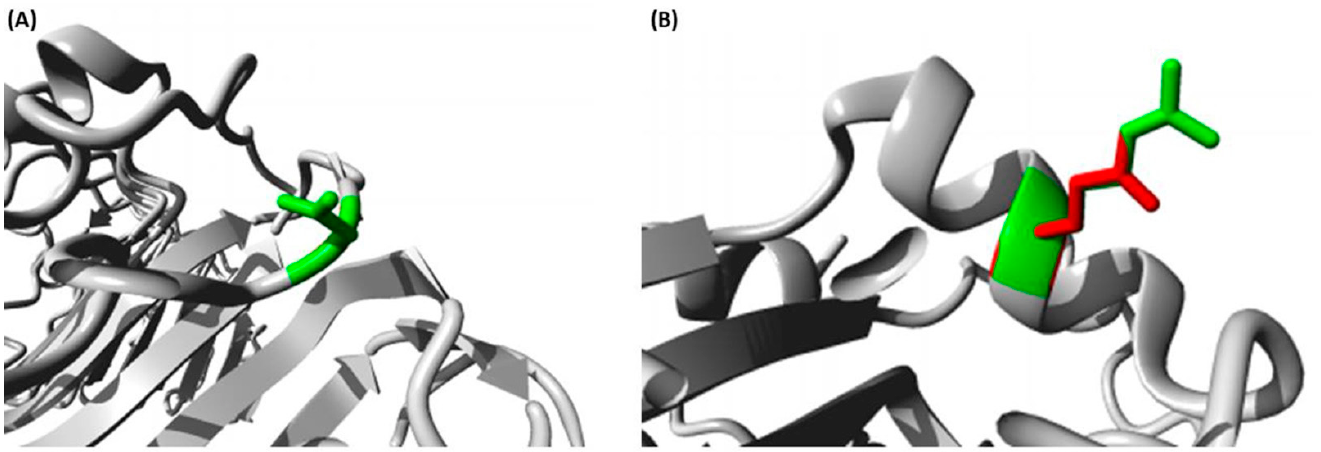
Figure 6. HOPE illustration of mutation structural impacts ( A ). Project HOPE illustration of the structural replacement of Aspartic acid with Glycine at position 299 in the TLR4 protein (colored with grey). The side chain of the wild type is colored in green while Glycine only has a hydrogen atom in its side chain ( B ). Project HOPE illustration of the structural replacement of Arginine with Glutamine at position 753 in the TLR2 protein (colored with grey). The side chain of the wild type is colored green while the side chain of the mutant type is colored red.